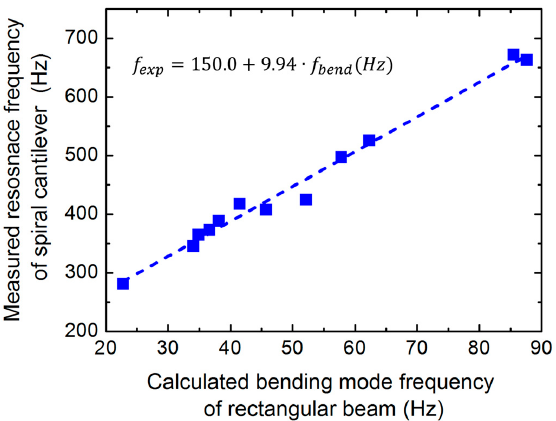
Figure 8. Experimental resonance frequencies for each cantilever as a function of the calculated first bending mode frequency using a simplified rectangular beam